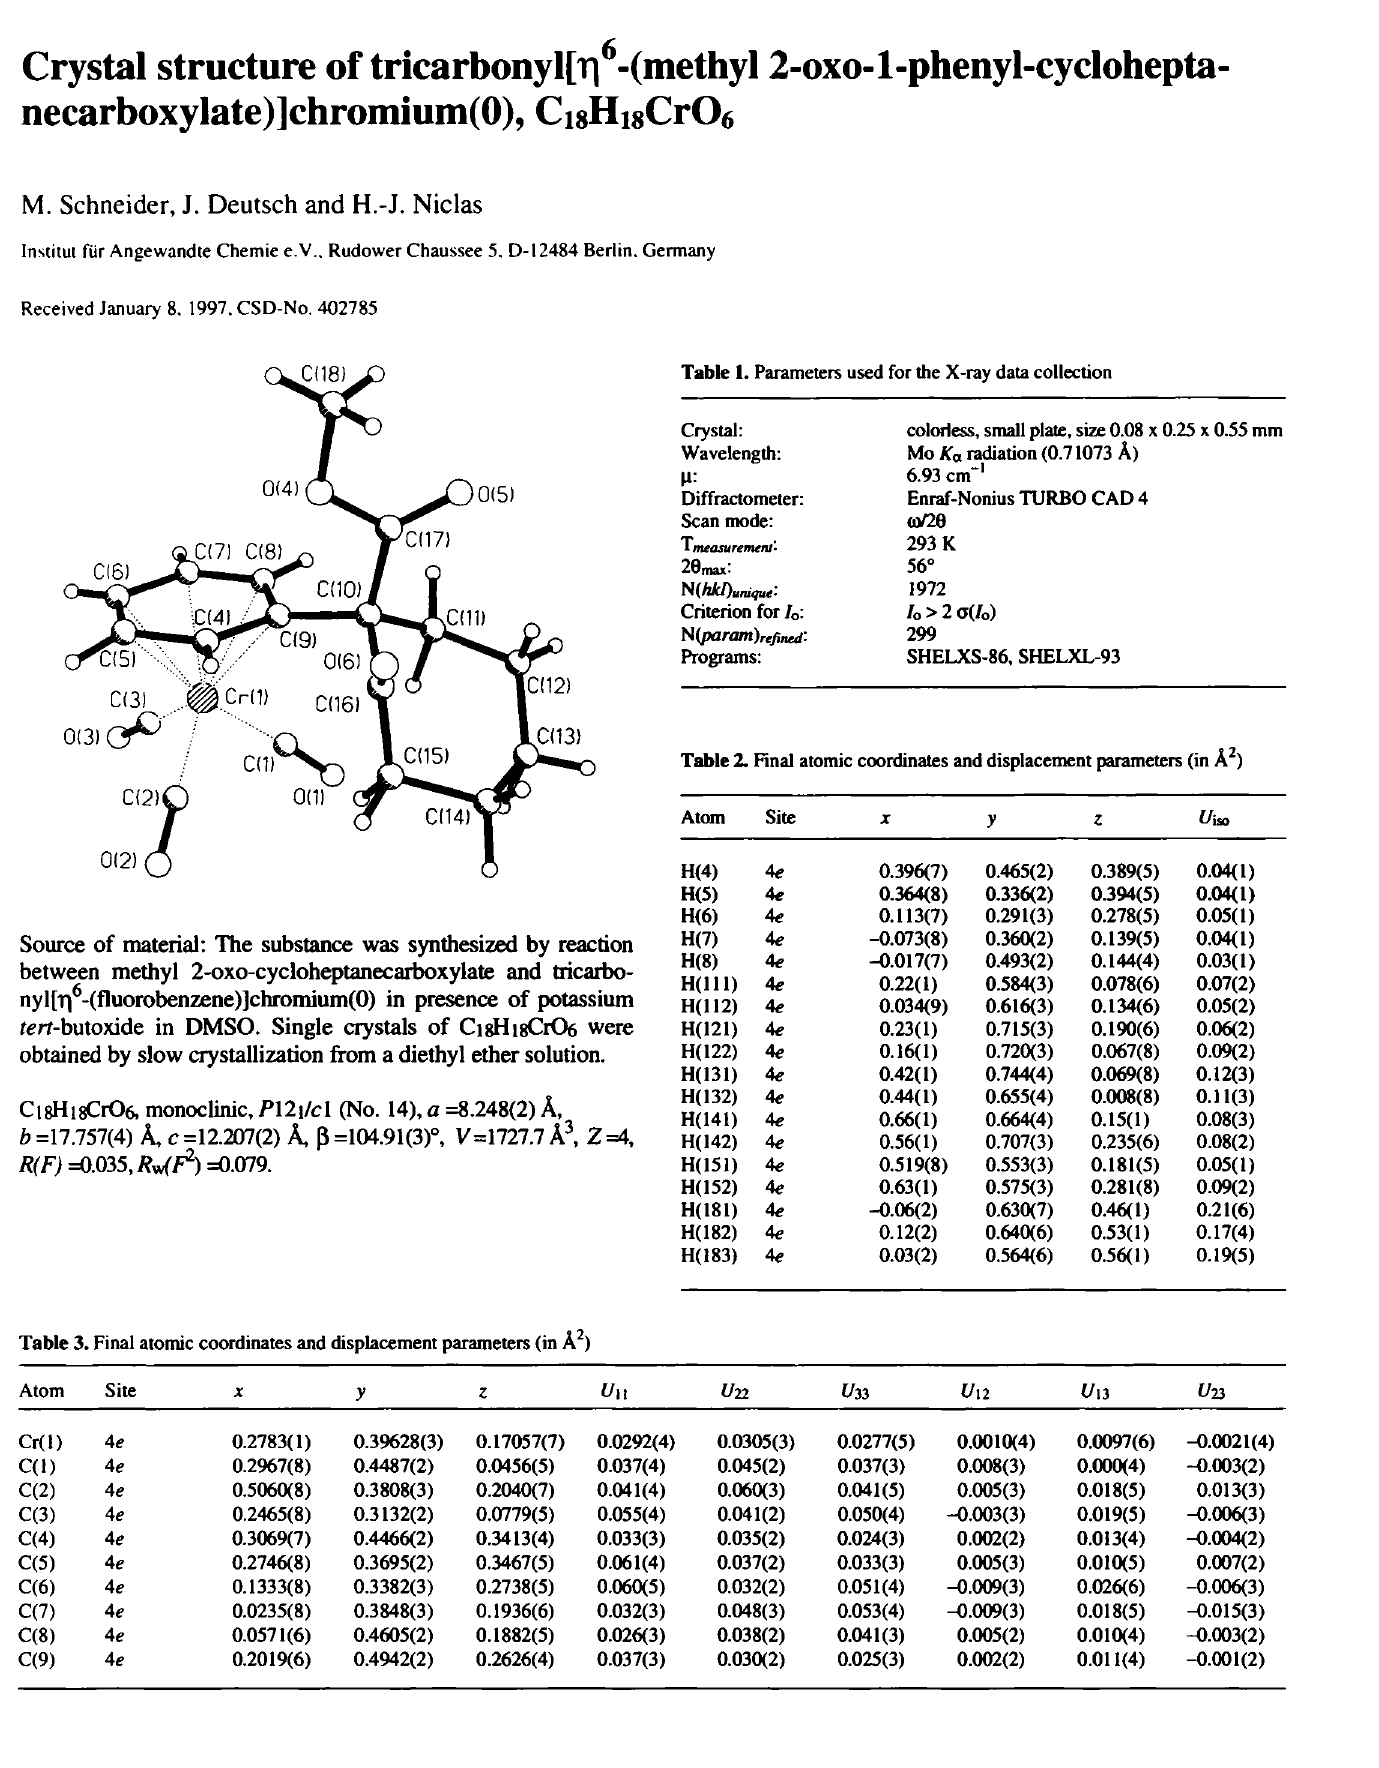
Table 1. Parameters used for the X-ray data collection